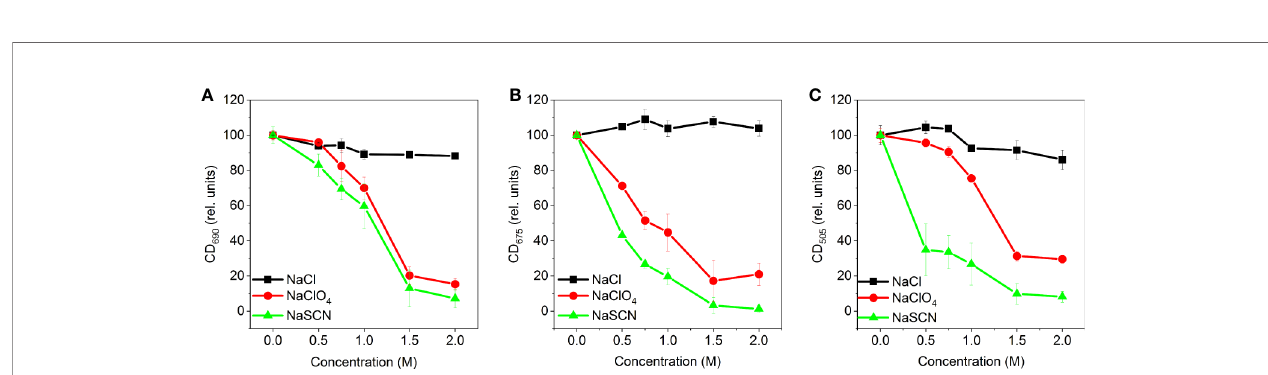
FIGURE 2 | Time-courses of the effects of different Hofmeister salts on the amplitudes of the different CD y bands of isolated pea thylakoid membranes: (A) (+)690 CD y , (B) (-)675 CD y , and (C) (+)505 CD y ; the corresponding CD amplitudes were determined with reference to the 750 nm signals. The membranes were treated at t= 0 min with 1 M (NH 4 ) 2 SO 4 , 1 M NaCl, and 1 M NaSCN, as indicated. Data points are representing the mean values of fi ve independent biological replicates